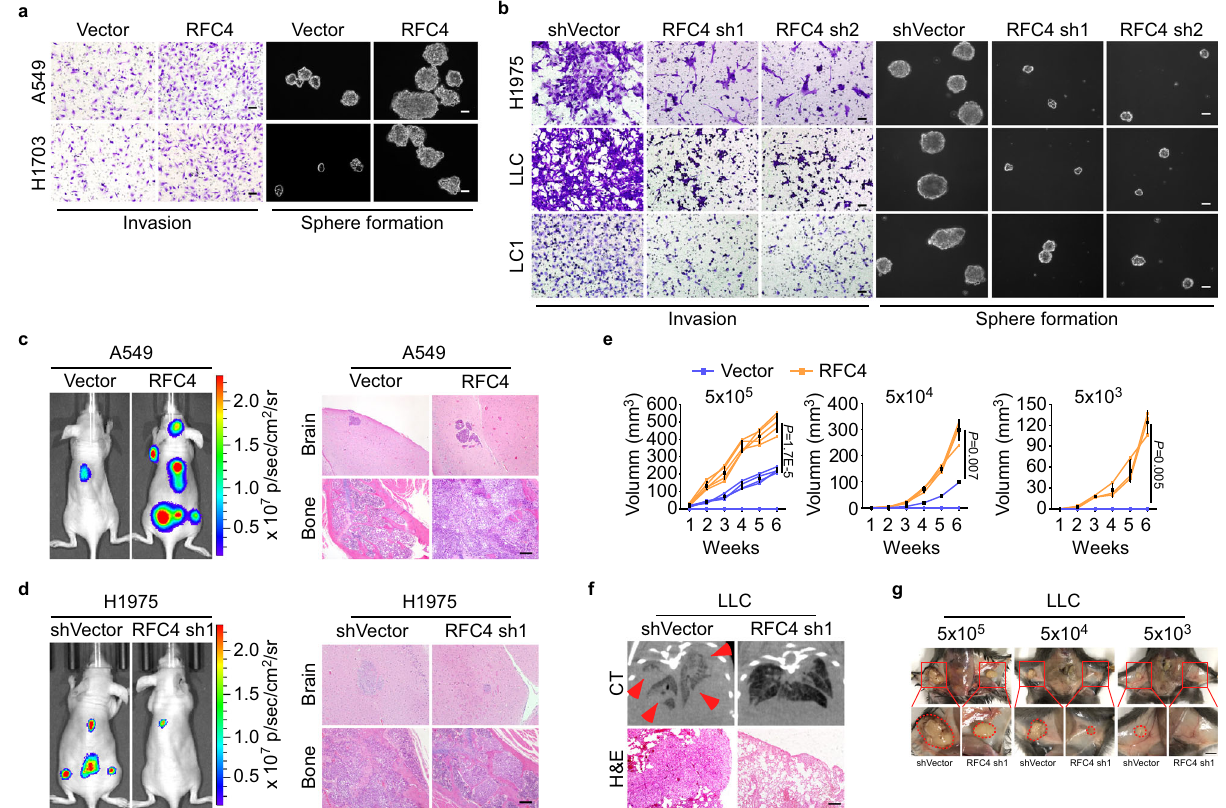
Fig. 3 RFC4 promotes NSCLC metastasis and stemness both in vitro and in vivo. a The effect of overexpressing RFC4 on the abilities of A549 cells to invade through matrigel or to form tumor spheres. Representative images of three independent reproducible experiments are shown. Scale bar: 50 μ m. b The effect of silenced RFC4 on the abilities of H1975, LLC, and LC1 cells to invade through matrigel or to form tumor spheres. Representative images of three independent reproducible experiments are shown. Scale bar: 50 μ m. c RFC4-overexpressing A549-luci cells were injected via cardiac ventricle into nude mice ( n = 5 per group). Representative bioluminescent images of systemic metastasis and ex vivo organ metastases are shown (left panel). H&E histologically con fi rmed tumor cells in brain and bone tissue (right panel). Two representative cases are shown. Scale bar: 100 μ m. d RFC4-slienced H1975- luci cells were injected via cardiac ventricle into nude mice ( n = 5 per group). Representative bioluminescent images of systemic metastasis and ex vivo organ metastases are shown (left panel). H&E histologically con fi rmed tumor cells in brain and bone tissue (right panel). Two representative cases are shown. Scale bar: 100 μ m. e Growth curves of tumor xenografts of RFC4-overexpressing A549 cells subcutaneously implanted with different cell numbers and tumor formation frequencies for indicated cell numbers are shown. f C57BL/6N mice ( n = 5 per group) were intravenously injected with RFC4- silenced LLC cells. Micro-CT imaging and H&E staining of two representative cases ’ lung tissue are shown. Scale bar: 100 μ m. g Tumor xenografts of RFC4- silenced LLC cells subcutaneously implanted with different cell numbers and tumor formation frequencies for indicated cell numbers are shown ( n = 5 per group). Three representative cases are shown. Scale bar: 2 mm. Data in panel e were presented as mean ± SD derived from three independent experiments. Two-way ANOVA multiple comparison analysis was used for statistical analysis. Source data are provided as a Source Data fi